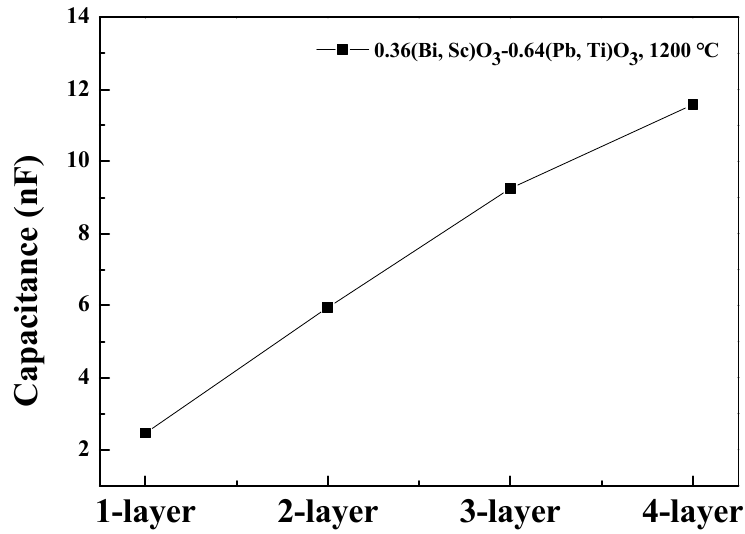
Figure 6. Measured capacitance of the 1–4 layer structured piezoelectric energy harvesters based on the BS-PT multilayered energy harvester.